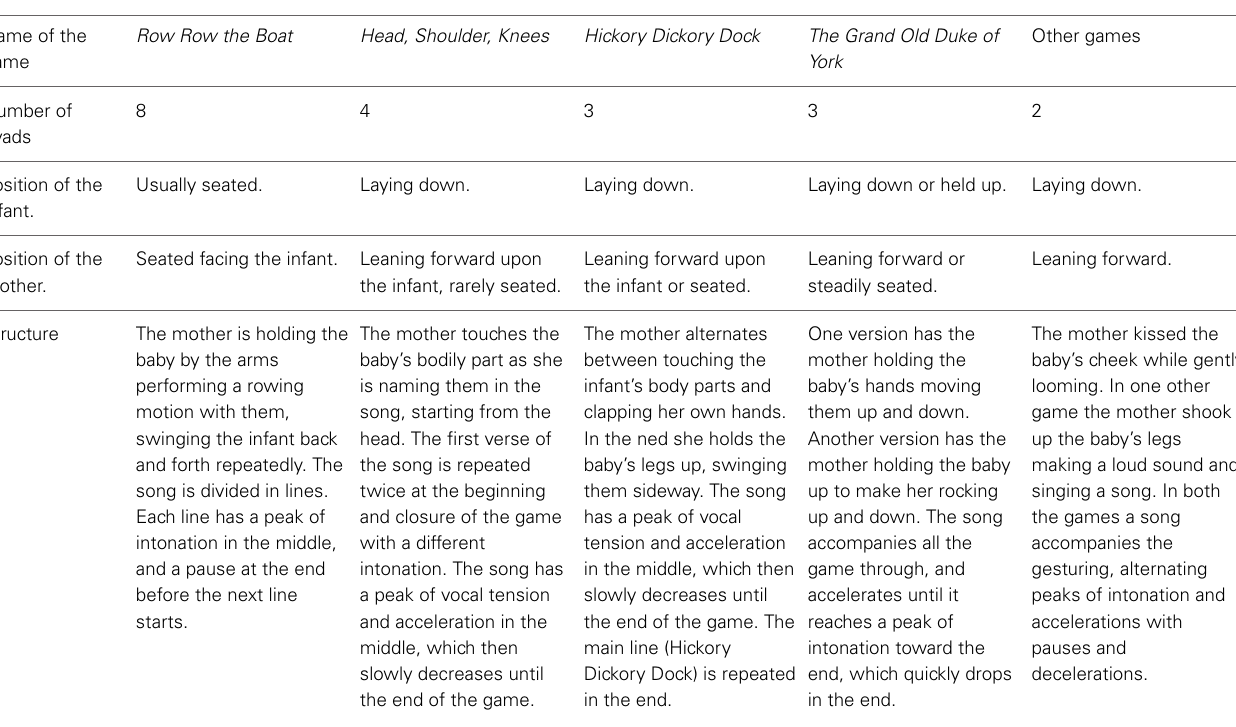
Table 2 | Types and structure of mother-infant early social